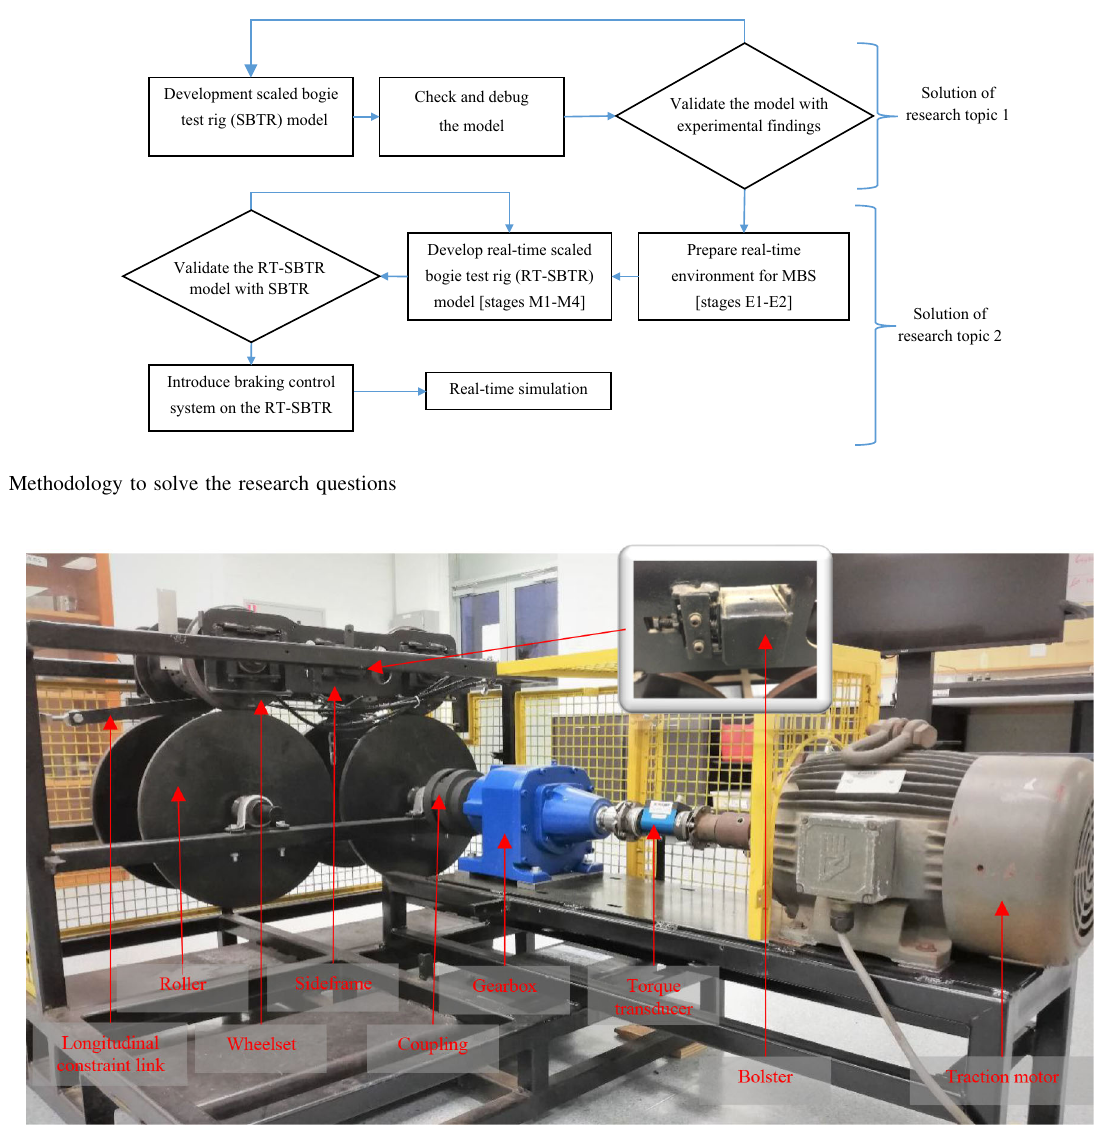
Fig. 3 Scaled bogie test rig in Centre for Railway Engineering, Centre Queensland University